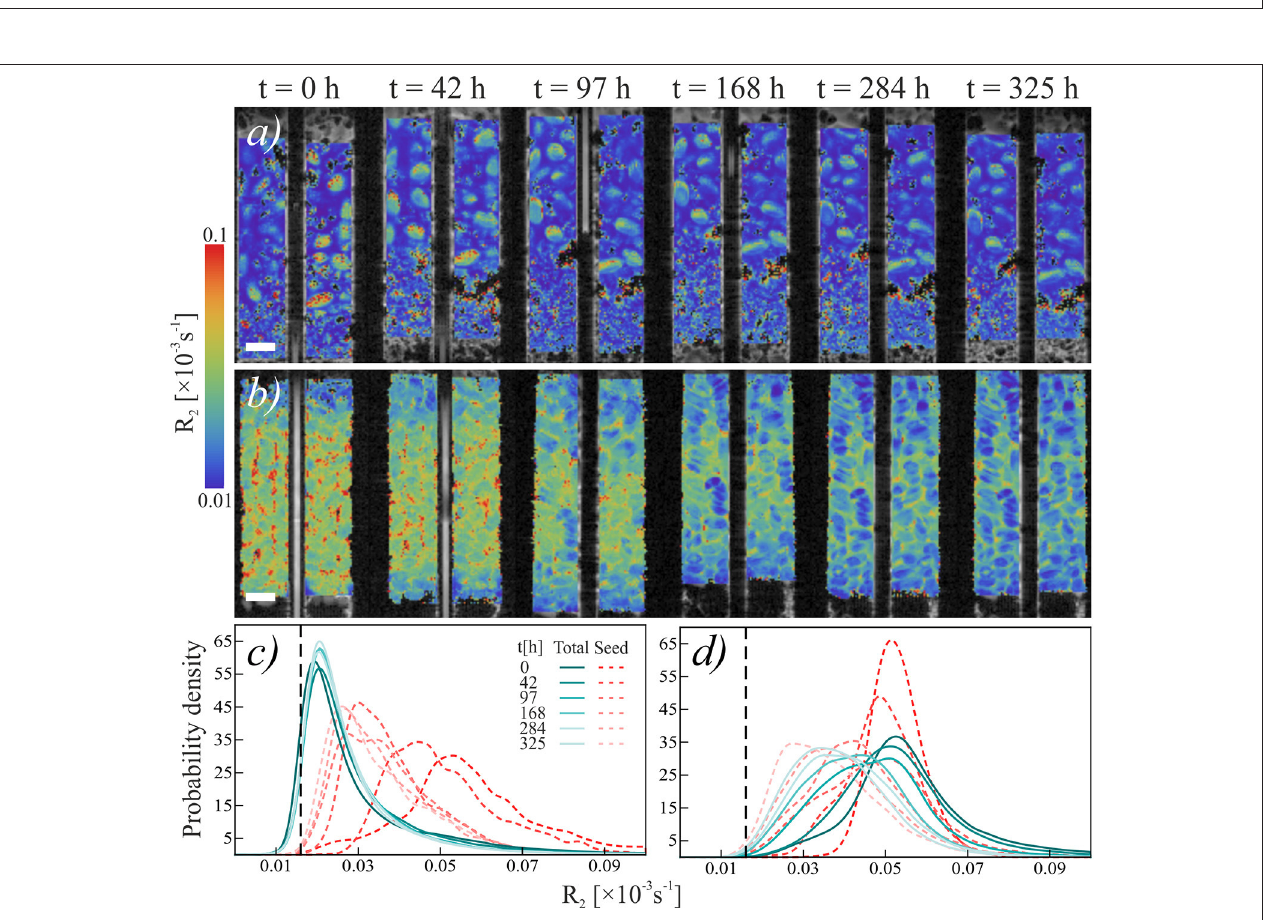
FIGURE 3 | Temporal development relaxation rate R 2 of chia seeds in Nafion. (a,b) Temporal sequence of NMR scans of (a) loose chia in Nafion and (b) packed chia in Nafion. Colors indicate relaxation rate R 2 . Scale bars are 2mm. (c,d) Histograms of relaxation rate R 2 of (c) loose chia in Nafion and (d) packed chia in Nafion. Blue-green solid lines show R 2 in “Total” region, red dashed lines show R 2 in “Seed” region. Black dashed reference line shows mean R 2 of water in the capillary, which is equal to the mean R 2 of water in Nafion pores ( R 2 = 0.016).